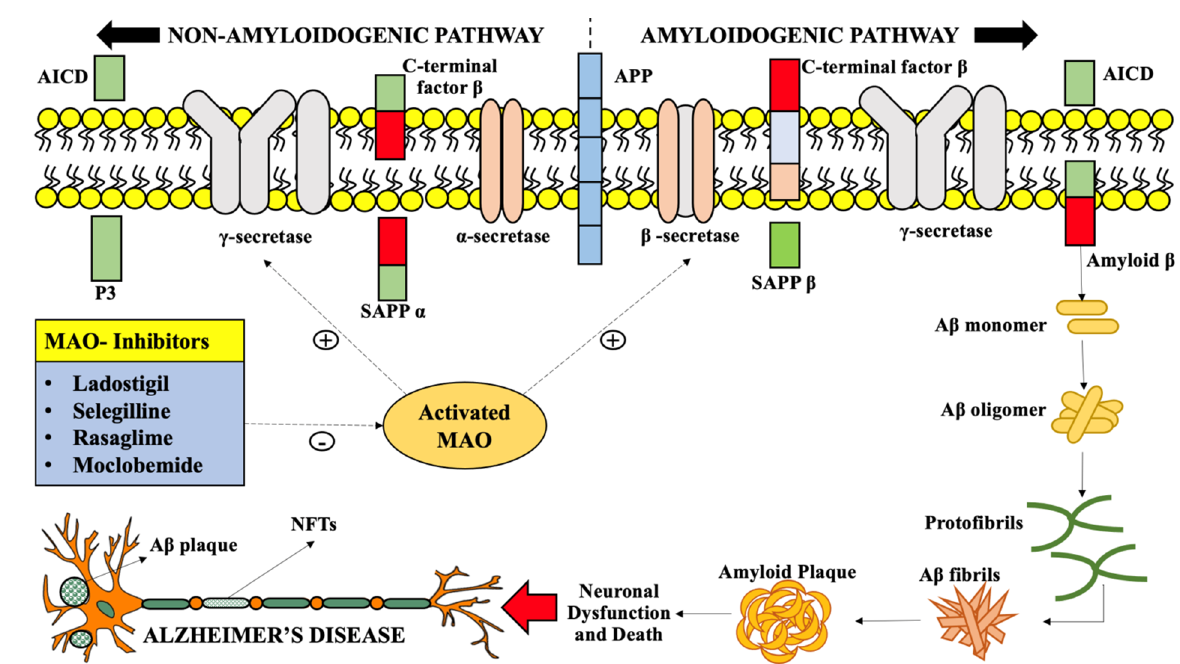
Figure 4. Overactive monoamine oxidase catalyzes the amyloidogenic and non-amyloidogenic cleavage of amyloid precursor protein by directly activating the beta-secretase and gamma-secretase activity, thus leading to aberrant amyloid plaque generation, a hallmark of Alzheimer’s disease. Legend: MAO—monoamine oxidase; NFTs—neurofibrillary tangles; A β —amyloid beta; APP—amyloid precursor protein; AICD—amyloid precursor protein intracellular domain; P 3 —amyloid peptide; sAPP α —soluble amyloid precursor protein alpha; C—terminal factor ß–carboxy terminal factor beta; Γ —secretase–gamma secretase; α —secretase–alpha secretase; ß—secretase–beta secretase.